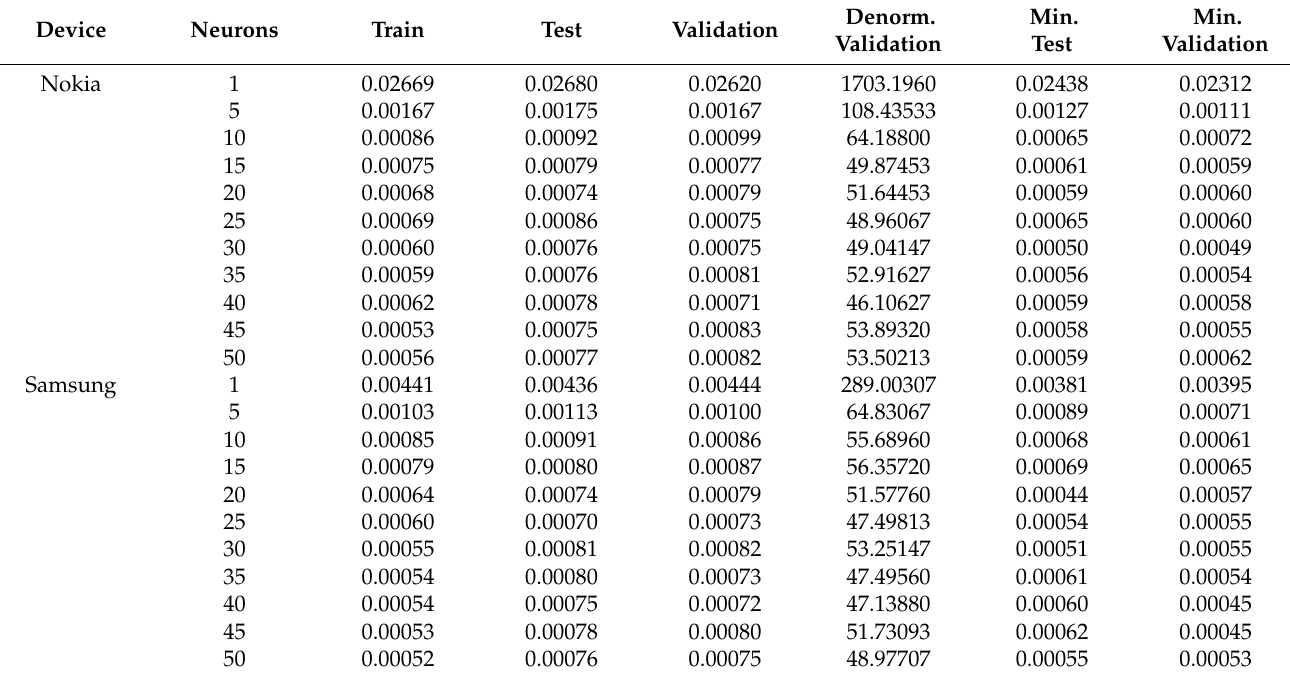
Table 2. Experiments for the reference gamut modelling.